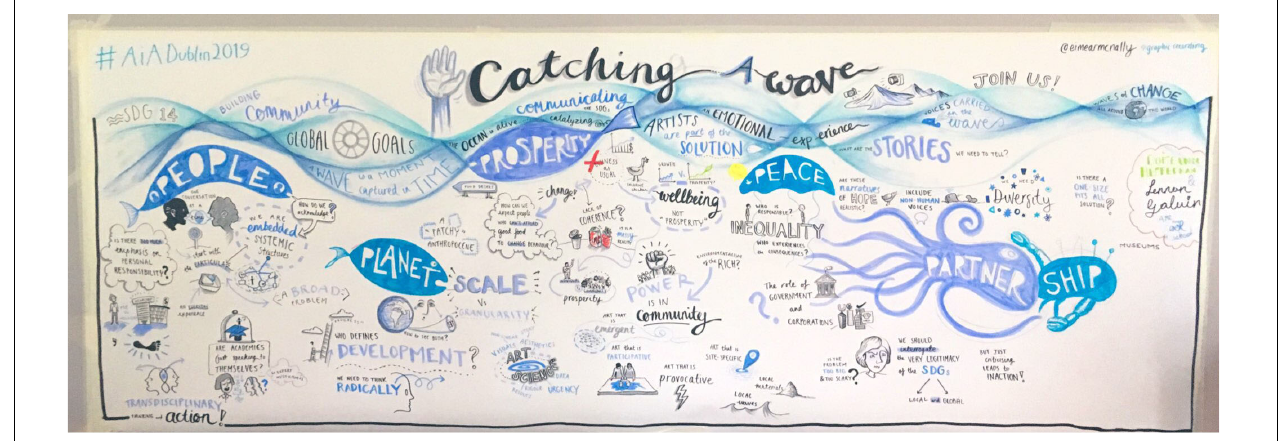
FIGURE 5 | A graphical recording of the CaW interactive workshop at the Art in the Anthropocene Conference 2019 that captured conversations and observations made by attendees. Graphic Artist: Eimear